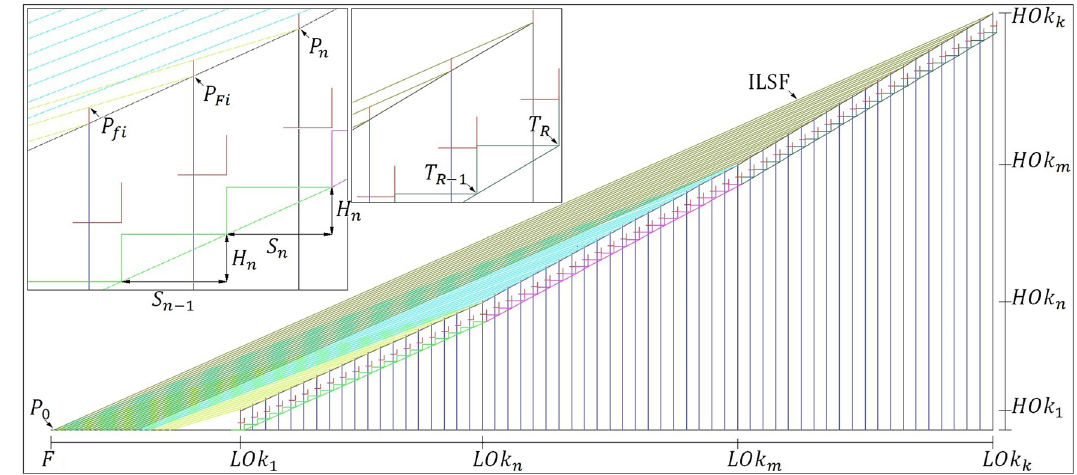
Figure 14: The pro fi le of the stand BA ( x